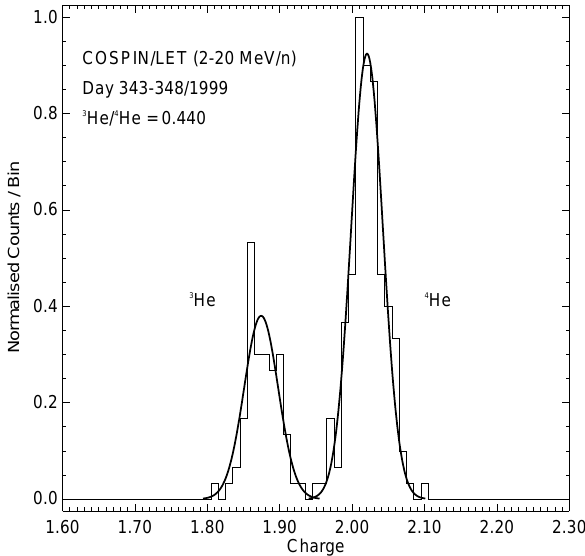
Fig. 1. An example of the charge histograms obtained from the D1:D2 pair of detectors for a 3 He rich event. The 3 He and 4 He populations are easily separated and are well-defined by standard Gaussian fits. Integrating the two Gaussian functions and taking their ratios yields the 3 He/ 4 He ratios used in this study. The his- tograms have been normalised to the maximum number of counts accumulated in a single charge bin during the complete event.